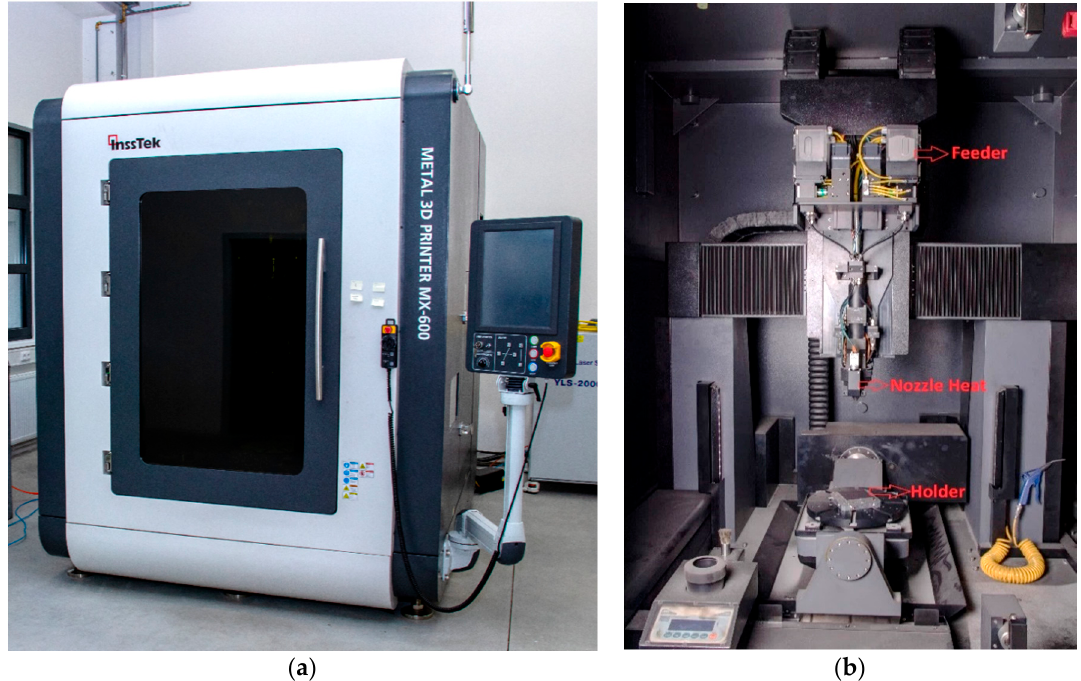
Figure 2. ( a ) InssTek MX-600 metallic deposition system ( b ) Deposition chamber.